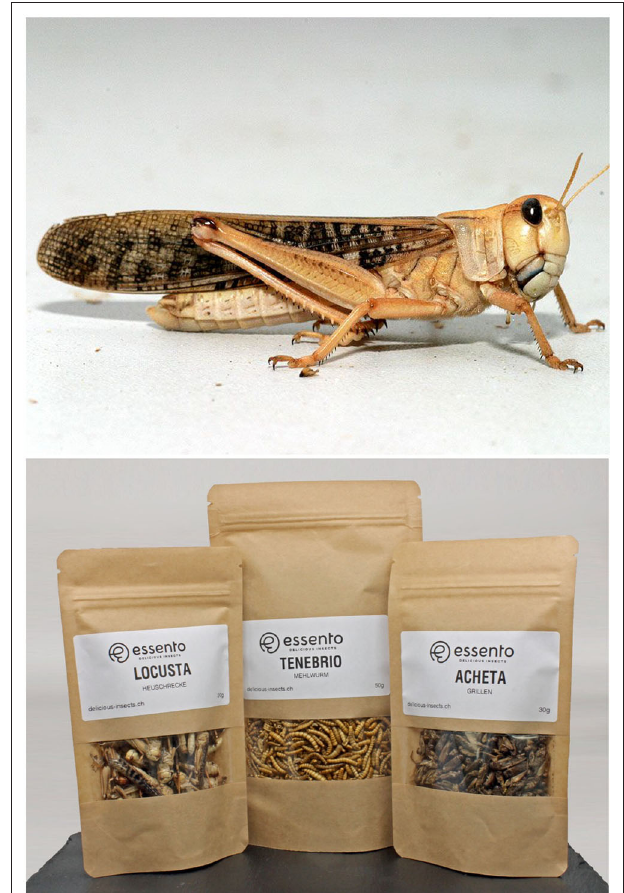
FIGURE 1 | Images of insect and products. It displays the image of the insect as displayed to participants (top panel) as well as the original packages (left side) sourced from the Swiss firm Essento Food AG (bottom